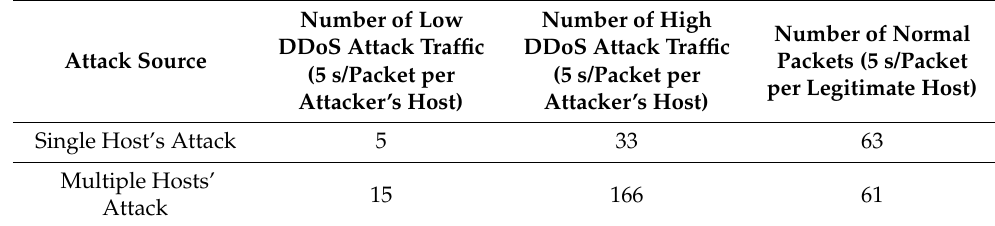
Table 2. Distribution of packets’ numbers for various DDoS attack traffic rates with the normal traffic. Number of Low Number of High DDoS Attack Traffic DDoS Attack Traffic Attack Source (5 s/Packet per per Legitimate Host) Attacker’s Host) Single Host’s